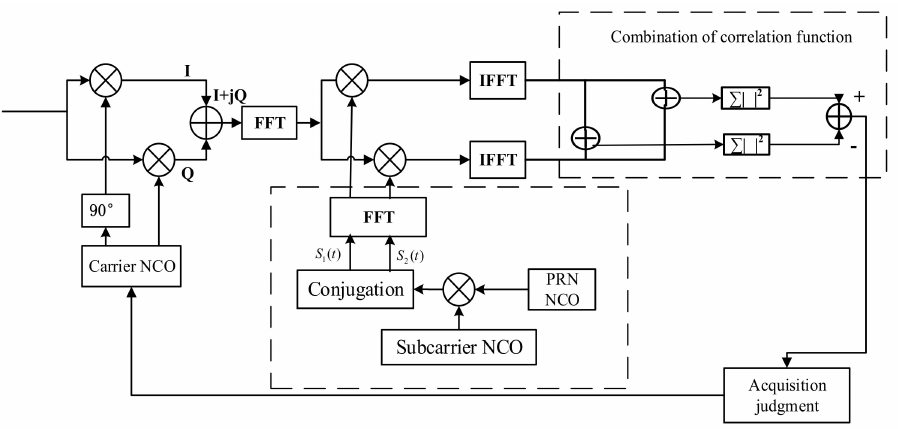
Figure 13. The acquisition structure schematic of the proposed method.